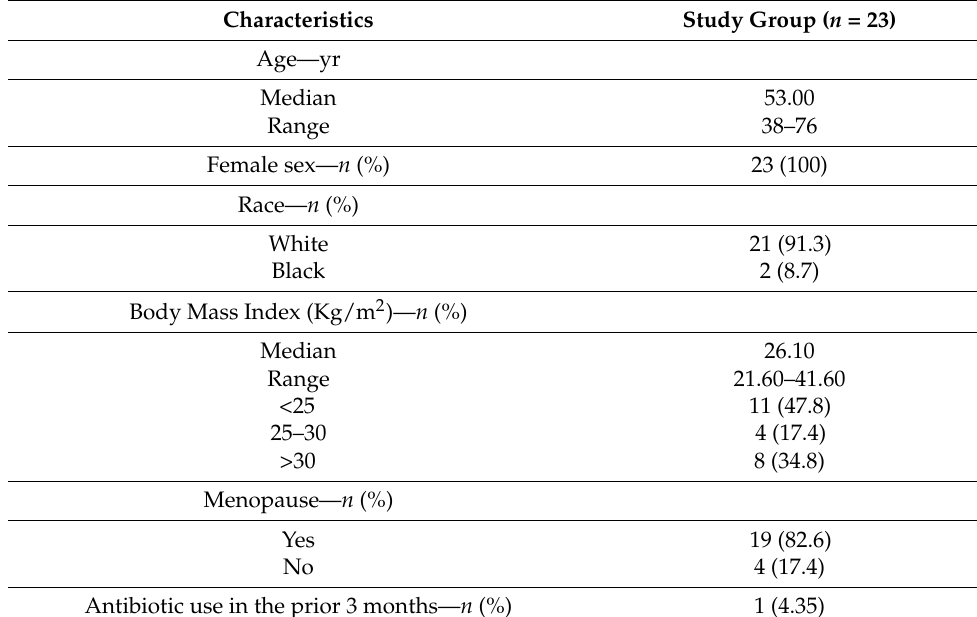
Table 1. Characteristics of patients at